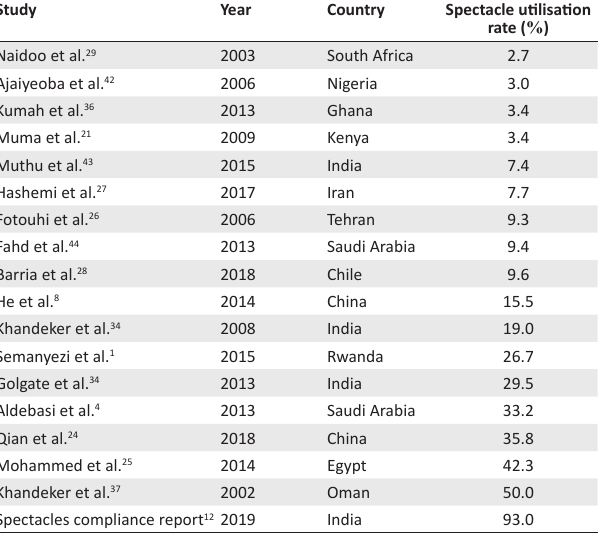
TABLE 5: Selected studies on spectacle utilisation in children in different countries.